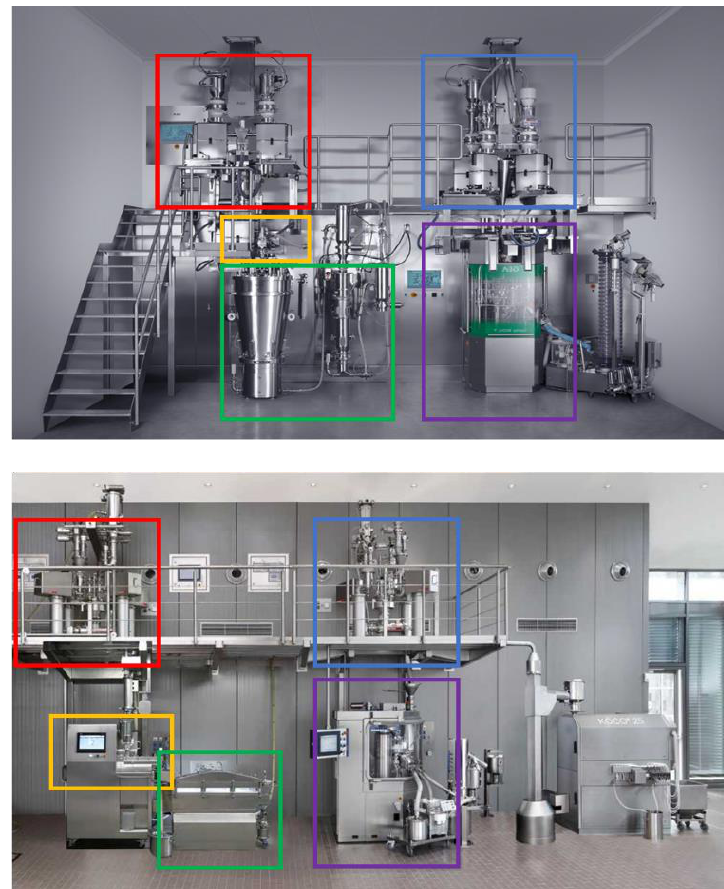
Figure 2. Setup of two fully integrated powder-to-tablet lines. ( Top ): Consigma by GEA Pharma Systems (adopted from www.gea.com; accessed on 9 April 2021); ( bottom ): QbCon by L.B. Bohle (courtesy of L.B. Bohle).